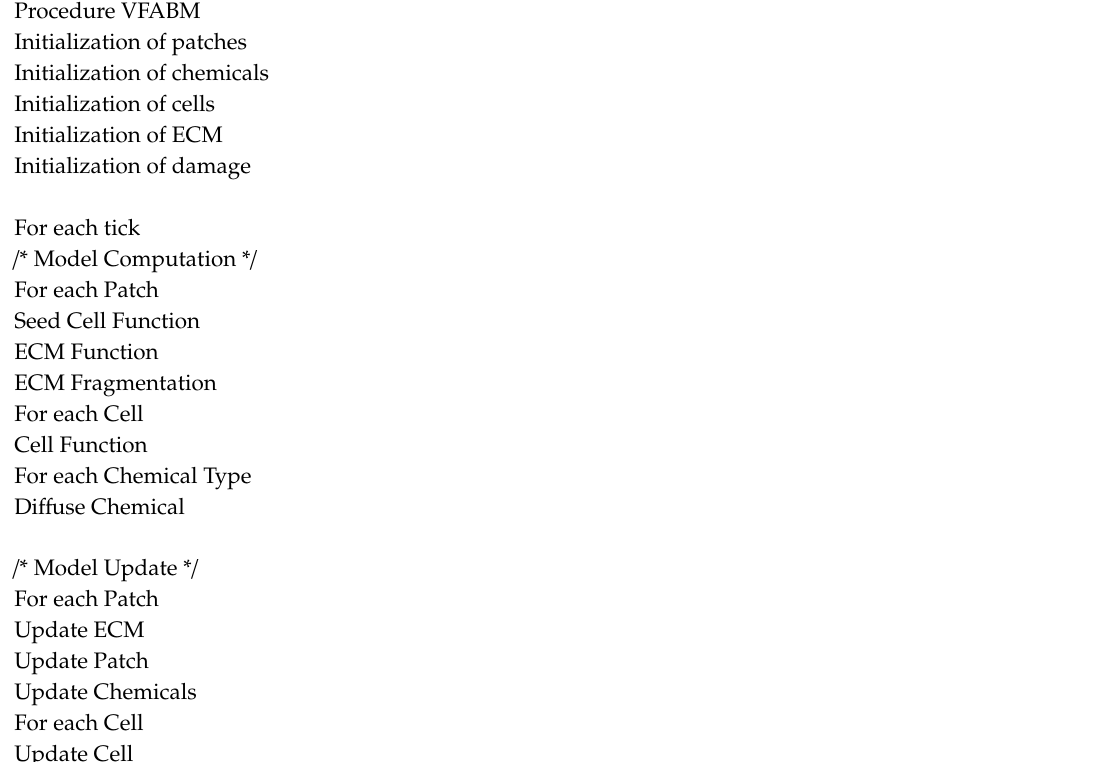
Algorithm 1: Overview of 3D rat vocal fold agent-based models (VF-ABM) Procedure